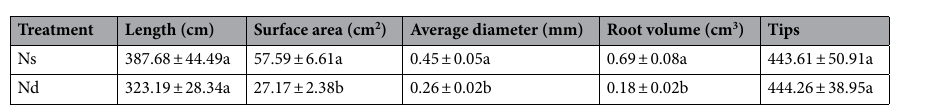
Figure 4. Effects of N-deficient conditions on alkaloid transporters, nicotine, soluble reducing sugar, and weight of tobacco roots. ( A ) Expression pattern of genes related to alkaloid transports; ( B ) nicotine content; ( C ) soluble reducing sugar content and root weight. Symbol ** indicates a statistically significant differences between nitrogen-deficient and nitrogen-sufficient conditions at p < 0.01. ns indicates no statistically significant difference between nitrogen-deficient and nitrogen-sufficient conditions at p < 0.05 and p < 0.01, respectively. Error bars of leaf biomass indicate standard error of the means (n = 3).